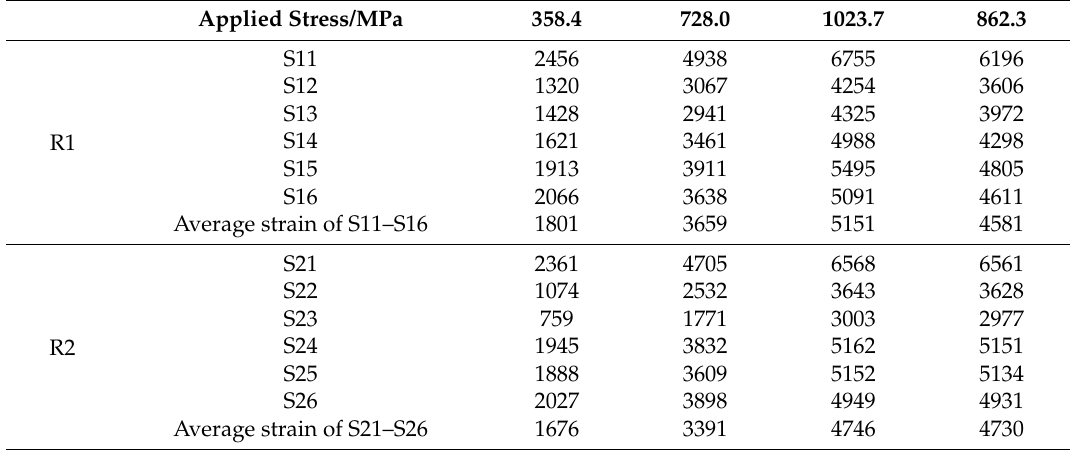
Table 11. The monitored strains of the strands at tensioning. (Unit: µε ). Applied Stress/MPa